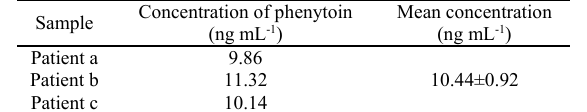
Table 3. Real sample analysis: the concentration of pheynitoin in plasma samples taken from patients treated with phenytoin